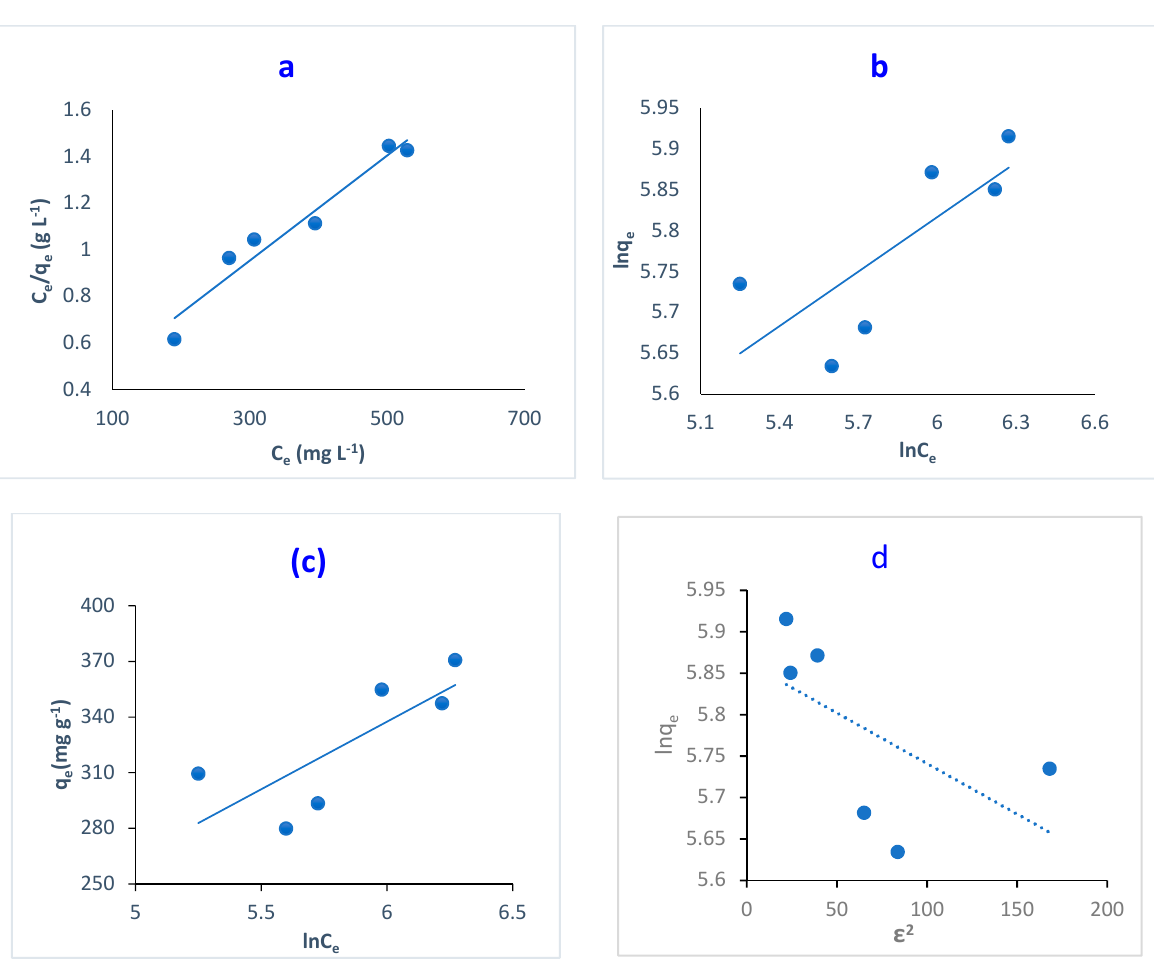
Figure 12. Linear adsorption isotherm for the removal of MB dye by O -CM-chitosan hydrogel; ( a ) Langmuir isotherm, ( b ) Freundlich isotherm, ( c ) Temkin isotherm, and ( d ) D-R isotherm models. Table 3. Adsorption isotherm parameters for removal of MB dye by O -CM-chitosan hydrogel .